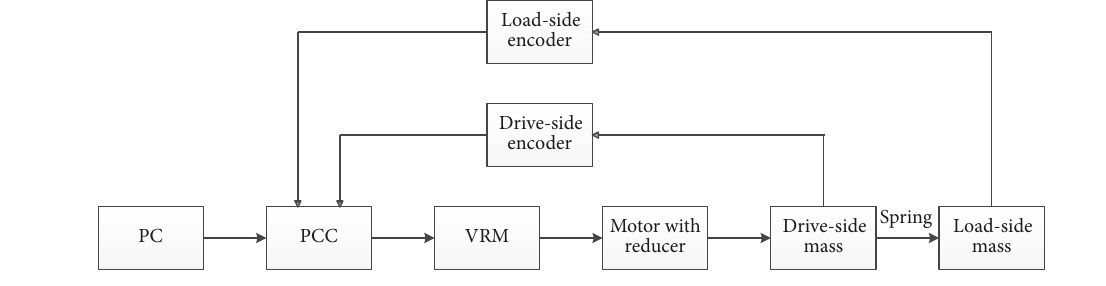
Figure 2: The structure of the experimental system.